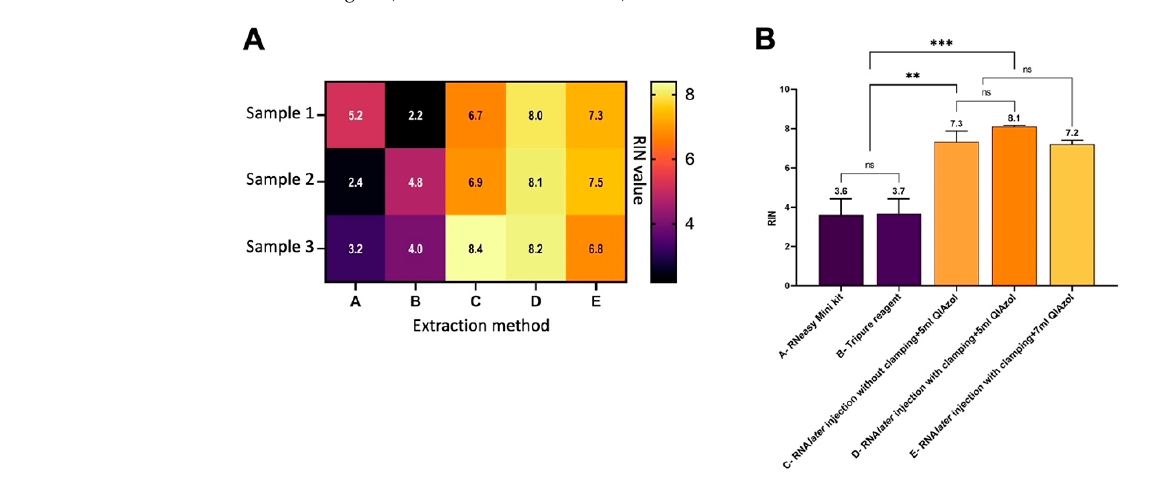
Figure 4. Electropherograms generated by an Agilent 2100 Bioanalyzer using the pico kit showing ( A ) RNA extracted using a standard protocol with an RIN = 3.6 and high peaks in the 5S and fast region, which indicates RNase degradation as compared with ( B ) RNA extracted using our